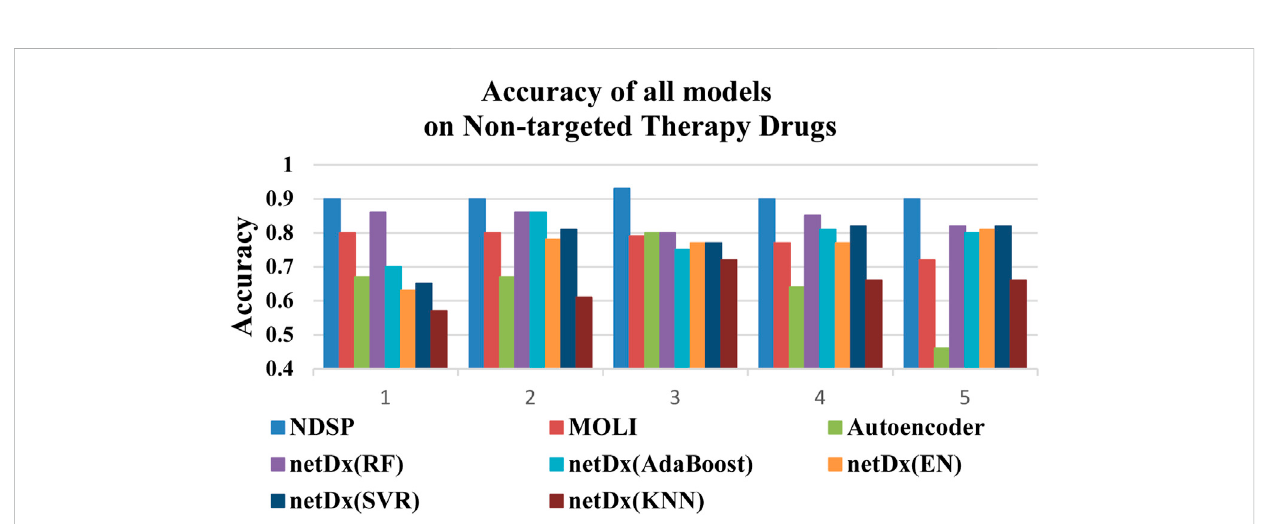
FIGURE 7 Accuracy of all 8 models on 5 non-targeted therapy drugs (1: FH535, 2: Vinblastine, 3: Z-LLNIe-CHO, 4: Imatinib, 5: Vinorelbine).